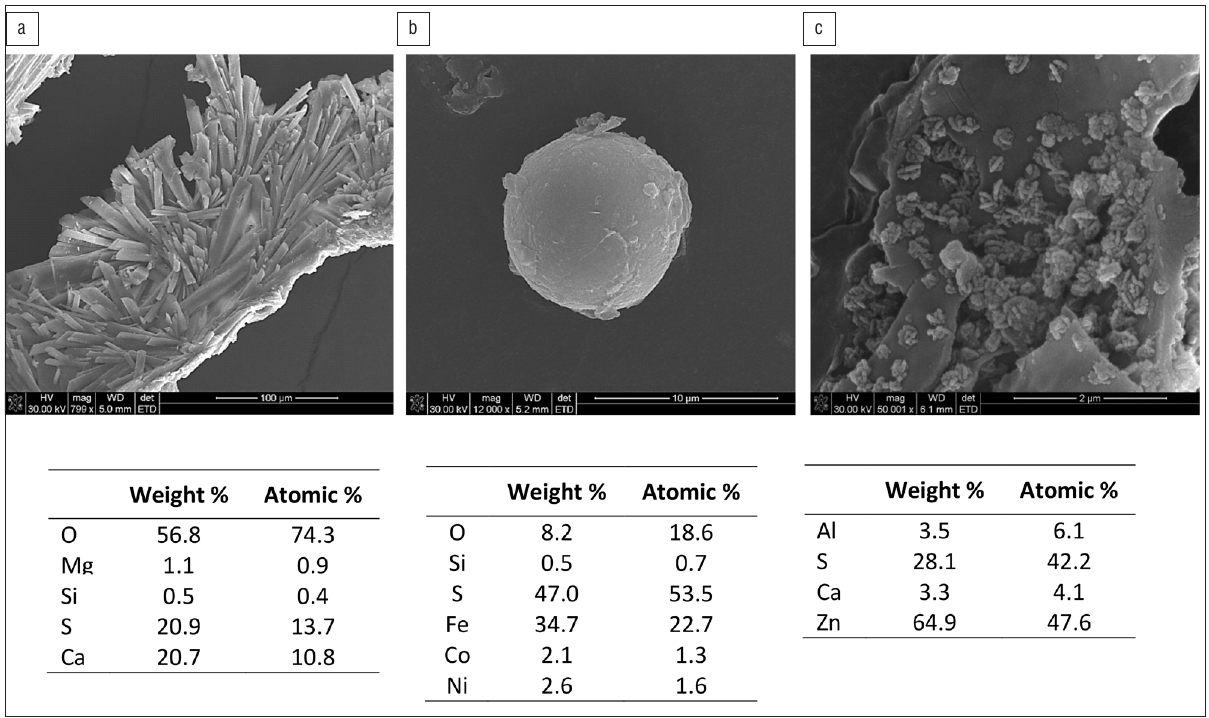
Figure 8: Scanning electron microscopy images and elemental results indicating various forms in which pollutants are sequestered within the peat: (a) precipitation of gypsum crystals (at 100 cm), (b) precipitation of Co- and Ni-enriched pyrite spheres (at 250 cm) and (c) formation of Zn sulfide clusters (at 250 cm). Table 4: Partitioning of metals in Core L1, defined using the BCR extraction procedure. Data are reported as averages ( n =12) with the predominant fraction shown in